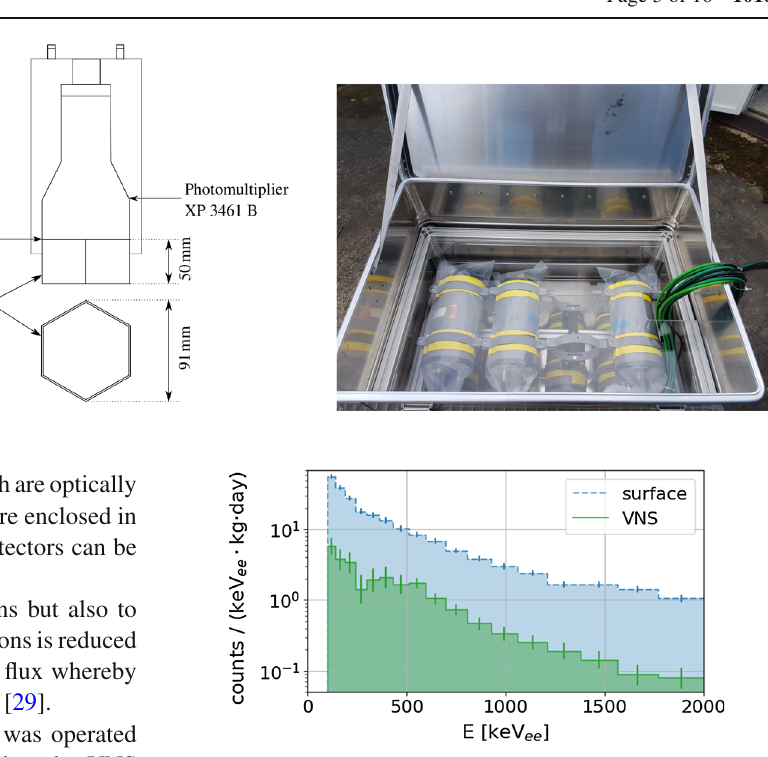
Fig. 6 Neutron-induced recoil rate in the liquid scintillator detectors uptoanenergyof2 MeV ee observedattheVNS(greenhistogram,solid line)andanearbysurfacelocation(bluehistogram,dashedline).Forthe calculation the best three detectors in terms of discrimination threshold and stability are used. Each bin displays the exposure-weighted average of the rates from all detectors with a sufficiently low threshold, along with error bars following Poissonian statistics. The histogram uses log- arithmic binning with small bins at low energy to display the shape of the spectrum and large bins at high energy to account for the low